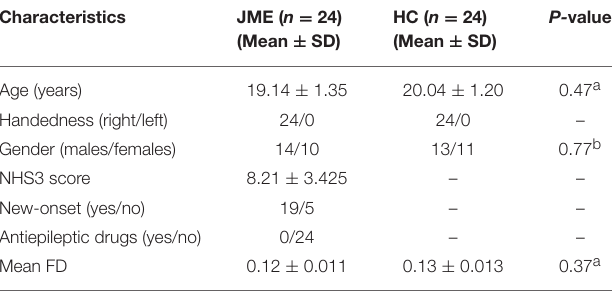
TABLE 1 | Demographics and clinical characteristics of the participants.